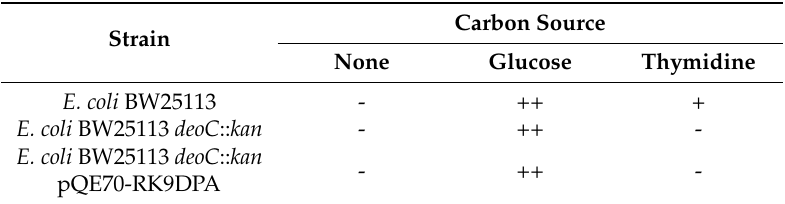
Table 1. Complementation assay of deoC − E. coli by transformation with pQE70-RK9DPA. Growth